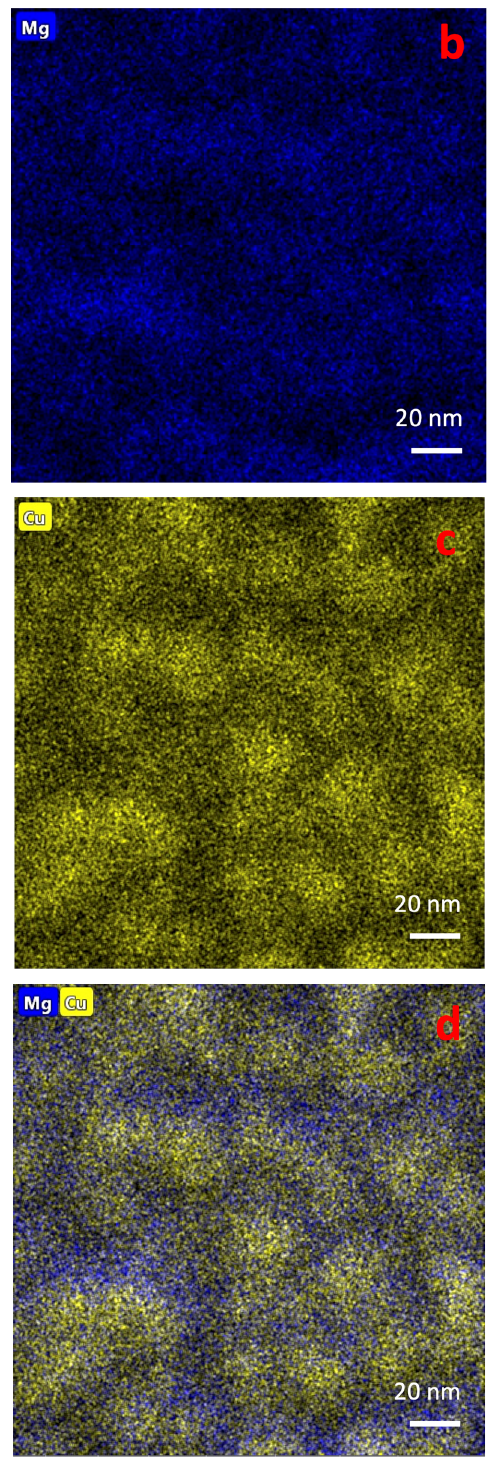
Figure 5. ( a ) Bright-field TEM image of Cu/MgO NP film obtained with co-deposition method; ( b ) EDX map obtained by measuring the intensity of the Mg EDX signal; ( c ) EDX map of Cu signal; ( d ) combination of maps ( b ) and ( c ).